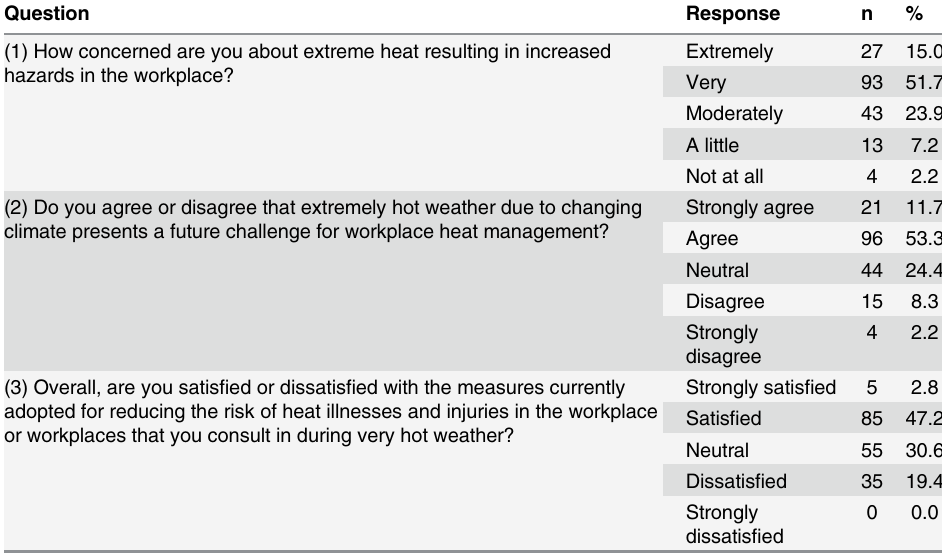
Table 2. Number and percentage of respondents' concern and awareness on workplace extreme heat exposure.